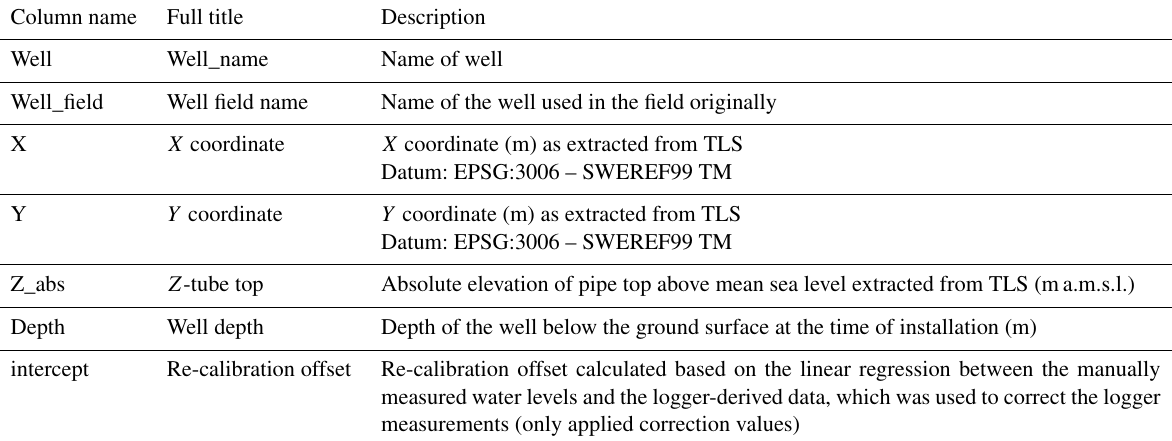
Table B1. Structure of the groundwater well location data file (2022-020_Erdbruegger-et-al_Krycklan_gw_wells.csv) and description of the column names.